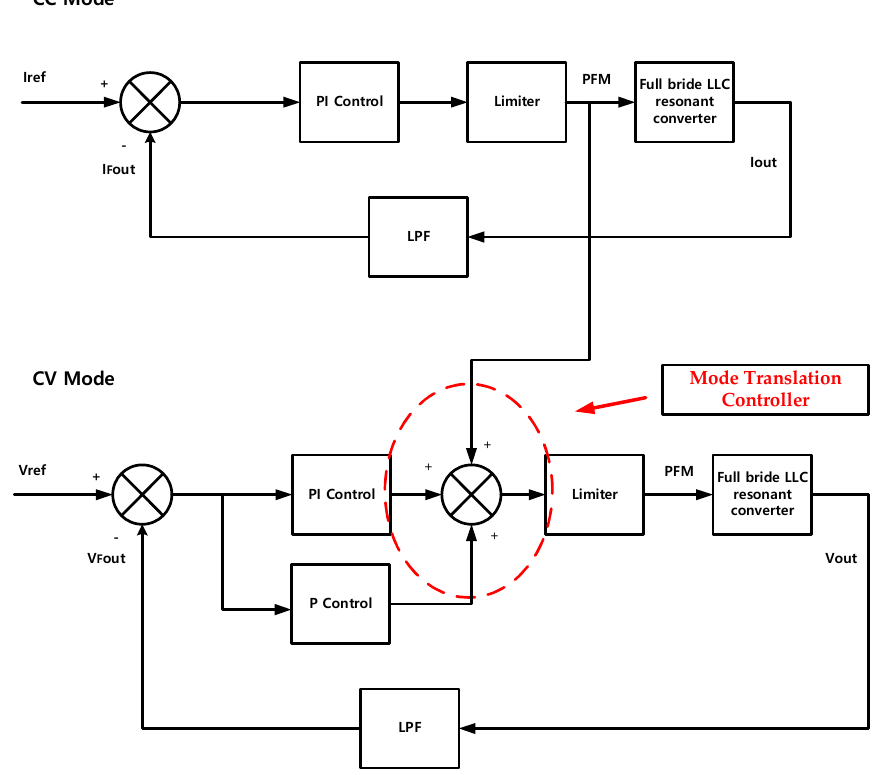
Figure 7. The proposed block diagram of the CC-CV (LIB).